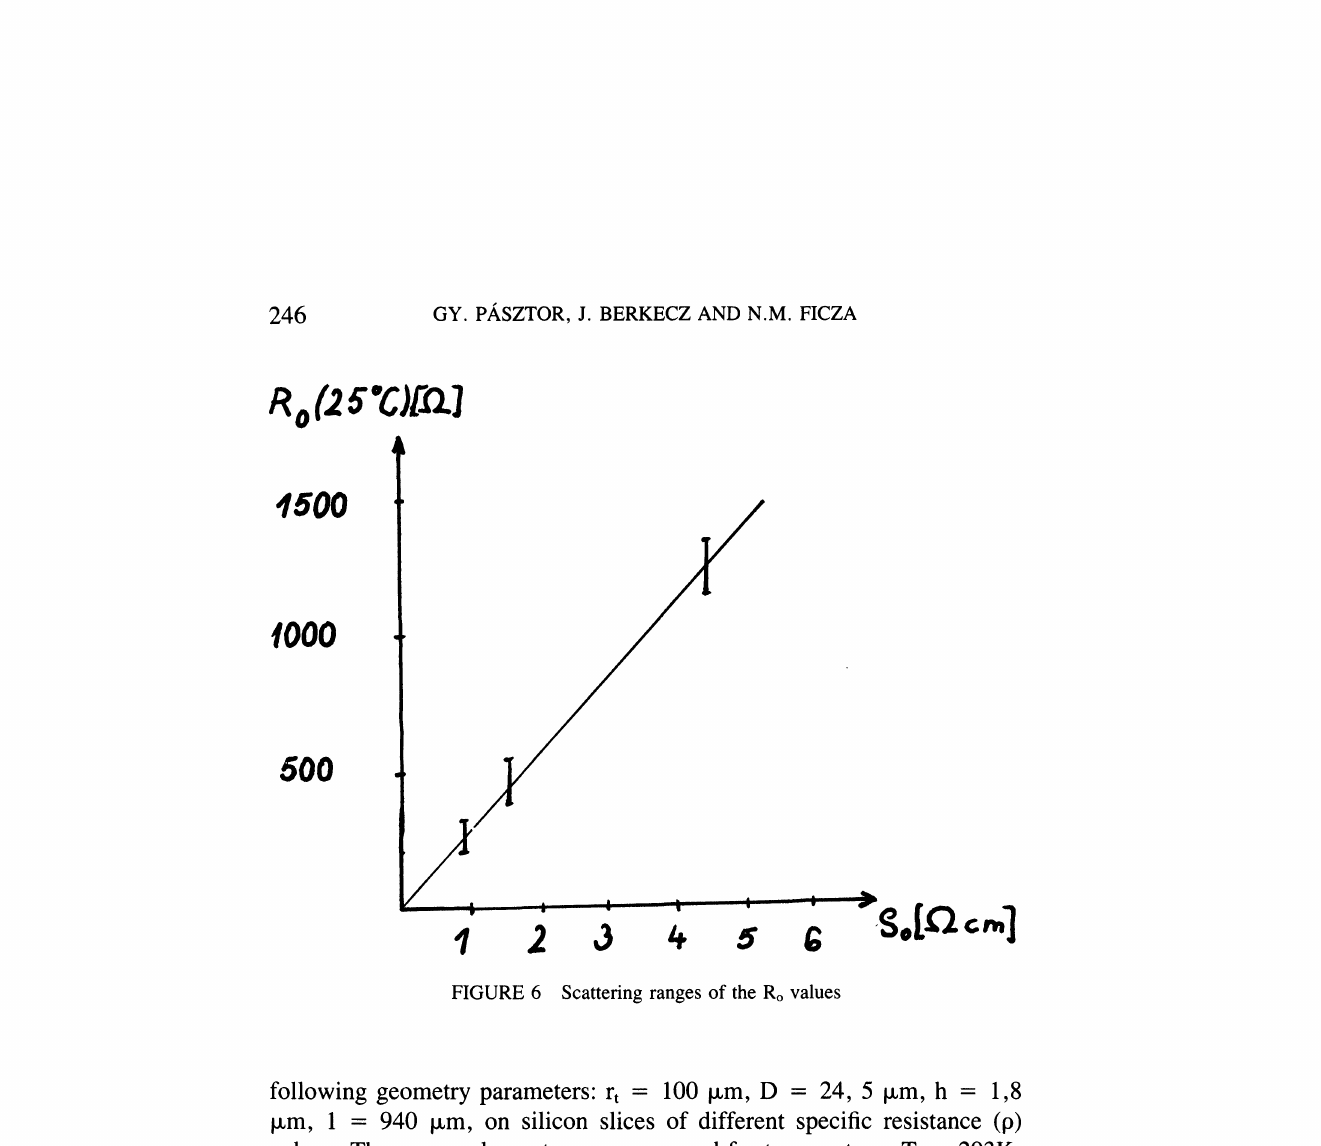
FIGURE 6 Scattering ranges of the Ro